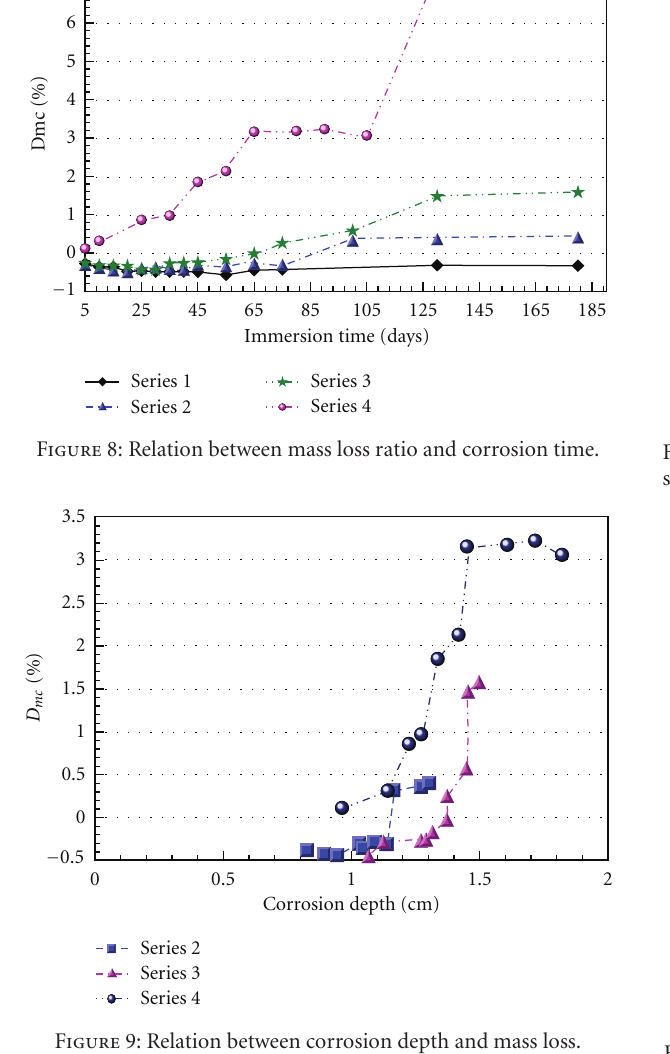
Figure 11: Relation between corrosion depth and Elastic